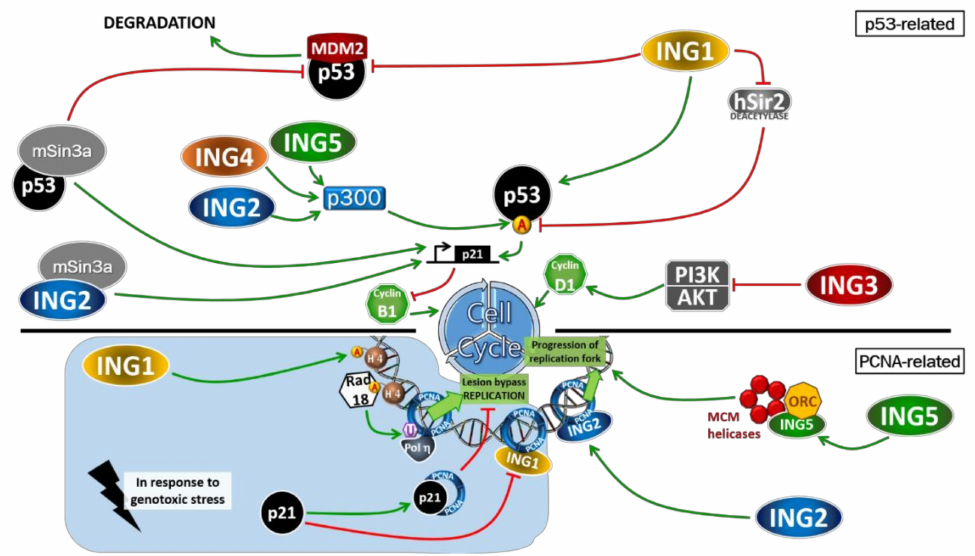
Figure 3. ING proteins regulate cell cycle in a p53-dependent and independent manner. Cell cycle is negatively regulated by INGs in various ways. UPPER PART: ING1 by interacting with p53 promotes its activation of p21. By inhibiting both deacetylase (hSir2) and degradation of p53, ING1 stabilizes p53. In addition, Sin3a can interact with p53 and stabilize it, then inhibiting MDM2-associated degradation of p53. ING2, ING4 and ING5 can induce negative cell cycle regulation through p300 activation leading to the acetylation of p53. In addition, ING2 in complex with mSin3A can directly activate p21 expression thus inhibiting cell cycle independently of p53. Finally, ING3 by inhibiting the PI3K / AKT activation, can decrease the expression of cyclin D1 resulting in cell cycle arrest. LOWER PART: in response to DNA damage or genotoxic stress, ING1 can facilitate lesion bypass and further replication by promoting Rad18 loading onto chromatin. In a more physiological way, ING2 interaction with PCNA promotes the progression of the replication fork onto chromatin. ING5 also helps this progression by interacting with the MCM helicases, then preventing replication fork collapsing or replicative